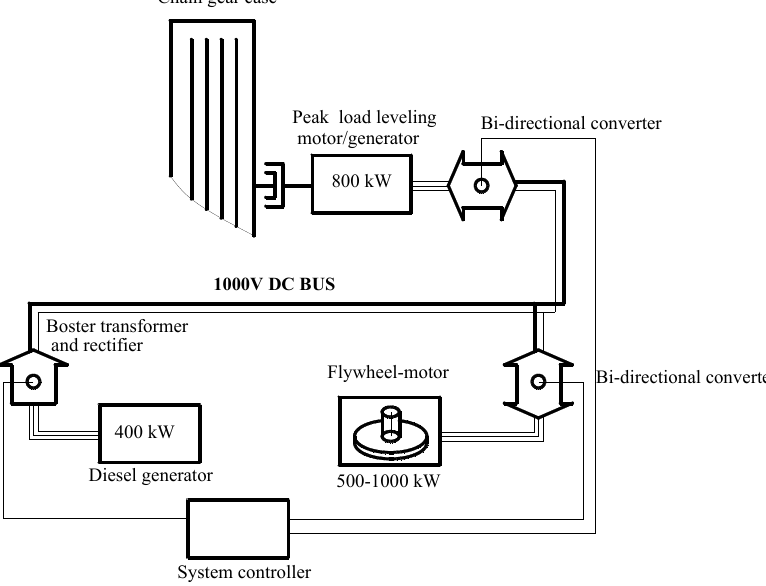
Figure 20. Electrical drive with flywheel energy storage.